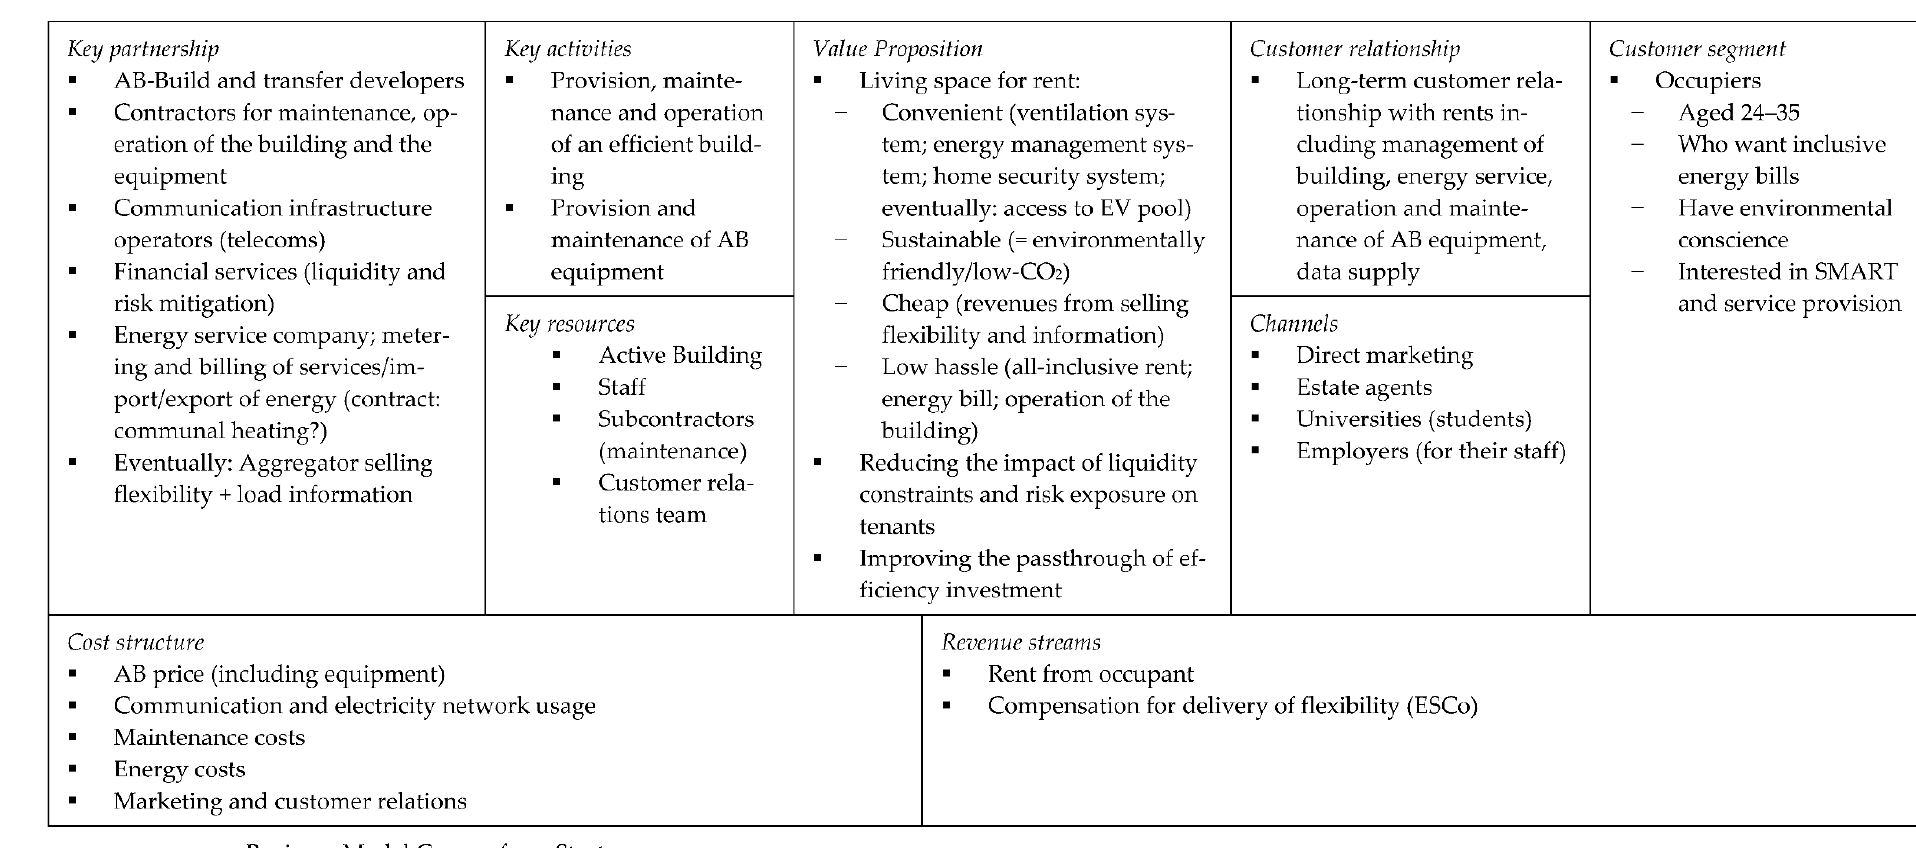
Figure 6. The “All - Inclusive” rental model . Figure 6. The “All-Inclusive” rental